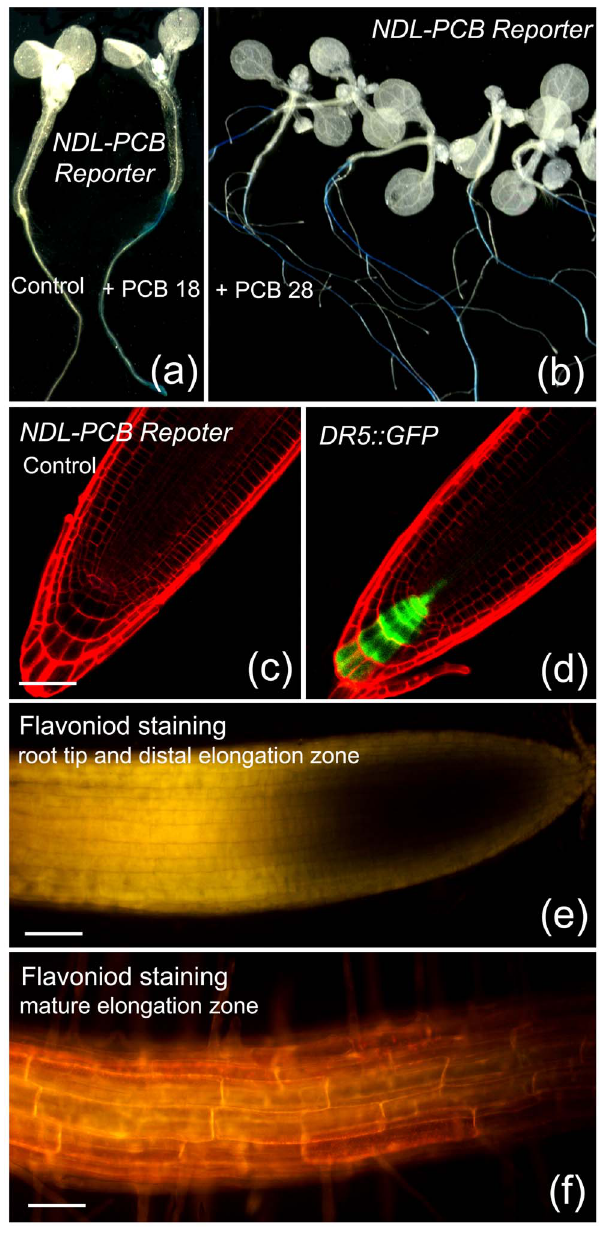
Figure 2. The expression of the reporter gene in NDL-PCB (non- dioxin-like polychlorinated biphenyl) Reporters was insensi- tive to endogenous secondary metabolites in living cells. (a) Histochemical assay of GUS activity in young seedlings of NDL-PCB Reporters. Three-day-old seedlings were transferred to plates without (control) or with 50 nM PCB 18 ( + PCB 18) and grown for 3 days. The right root under PCB 18 treatment was stained blue. (b) Histochemical assay of GUS activity in 12-day-old NDL-PCB Reporters. Six-day-old seedlings were transferred to plates with 50 nM PCB 28 and grown for 6 days. Roots under PCB 28 treatment were stained blue. (c) NDL-PCB Reporters were insensitive to endogenous auxin in root tips as no GFP signals were observed by confocal microscopy. The red PI (propidium iodide) indicated the cell wall. (d) The DR5::GFP line reported auxin peaks (GFP signals) in roots. (e) Naringenin chalcone (yellow fluorescence) in distal elongation zones and meristems of 10-d-old Arabidopsis roots. Meristematic cells were small in size. (f) Kaempferol and quercetin (gold fluorescence) in mature elongation zones of 10- day-old Arabidopsis roots. Bars for (c) to (f), 30 m